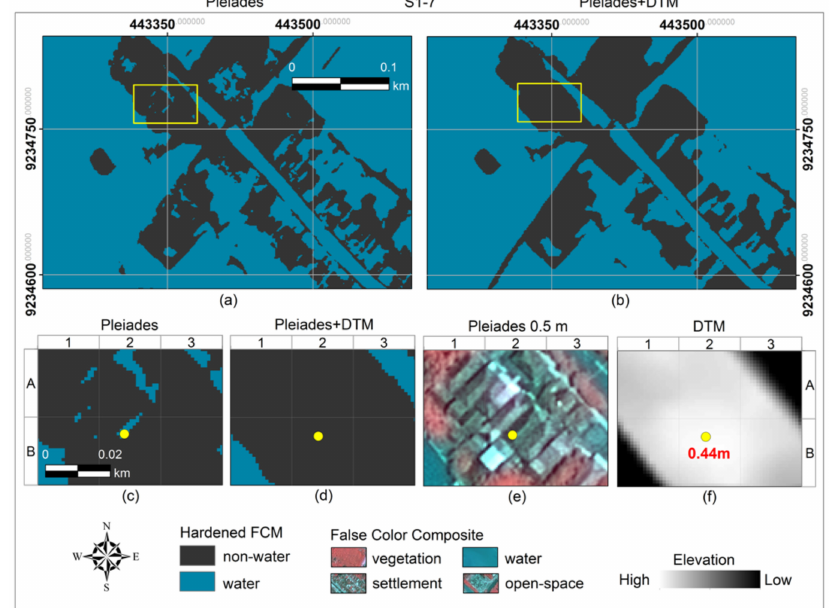
Figure 4. Comparison of the fuzzy classification results between: Pleiades ( a , c ); and Pleiades + DTM ( b , d ). Pleiades 0.5 m ( e ); and elevation data ( f ) are displayed to interpret the attribute of yellow